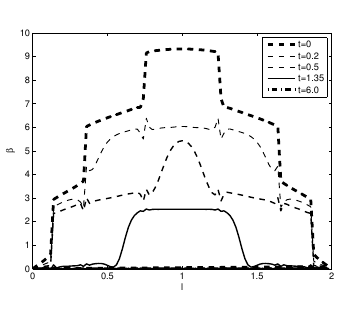
Figure 22. The dependence of max β on t for ωτ = 12 ⇒ 0 and using the reverse function.